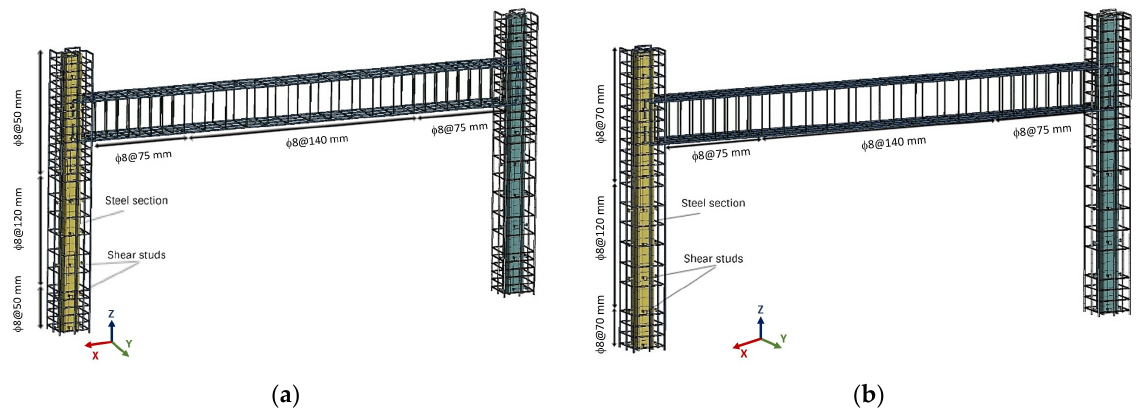
Figure 3. Reinforcement and steel section details of the frames in LS-DYNA: ( a ) HD; ( b ) LD. Table 2. Details of 12 frame models.